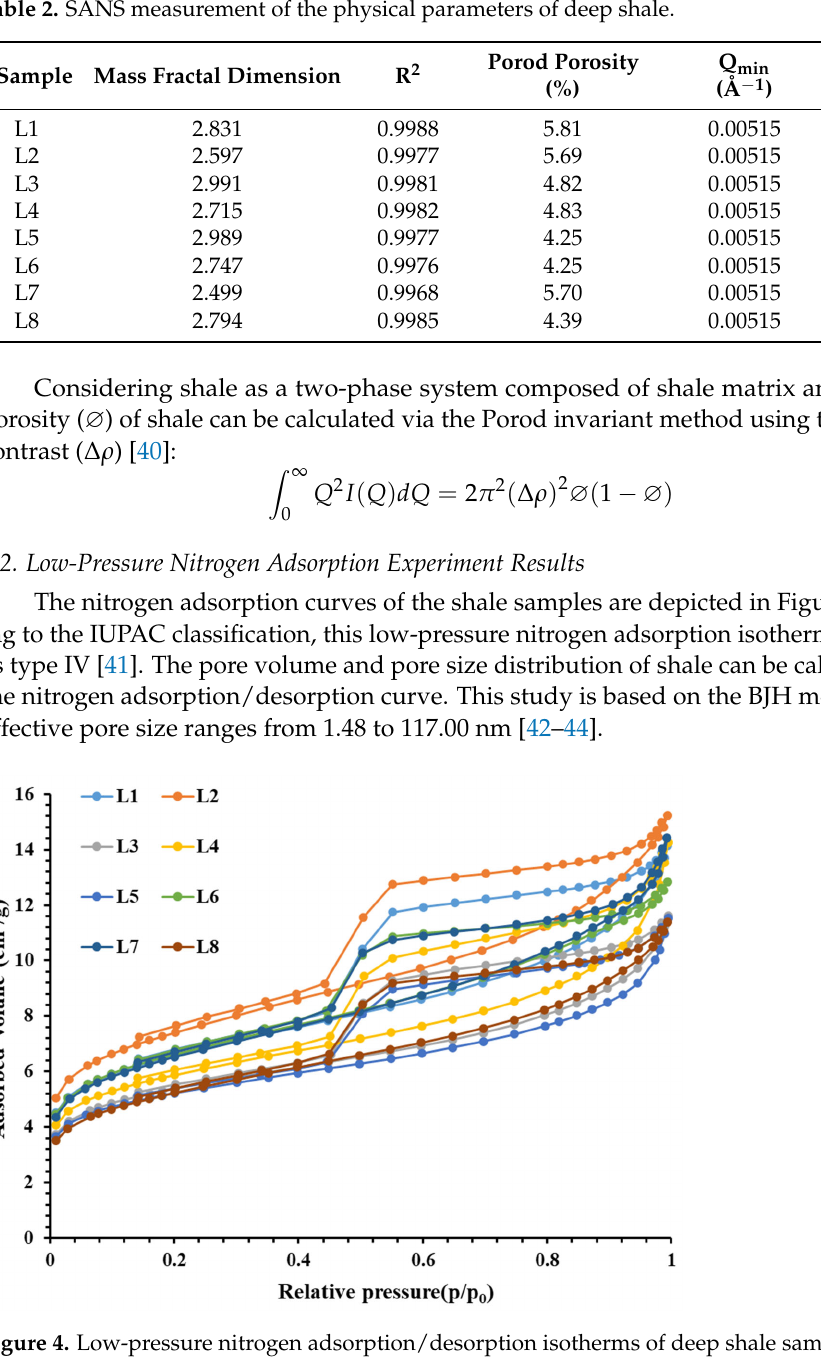
Table 2. SANS measurement of the physical parameters of deep shale.